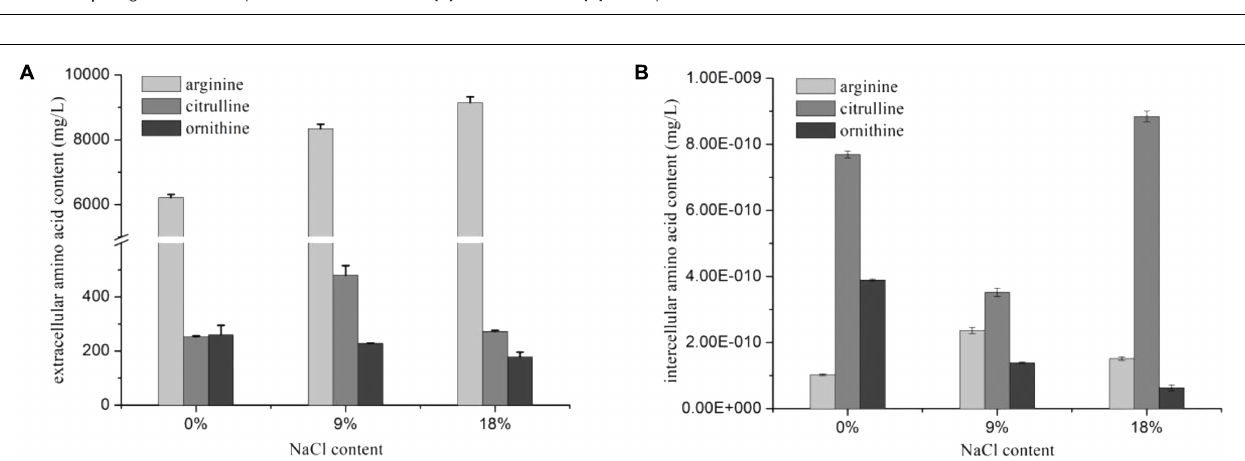
FIGURE 2 | arc gene relative expression of P. acidilactici (A) and W. confusa (B) in the presence of different NaCl contents.